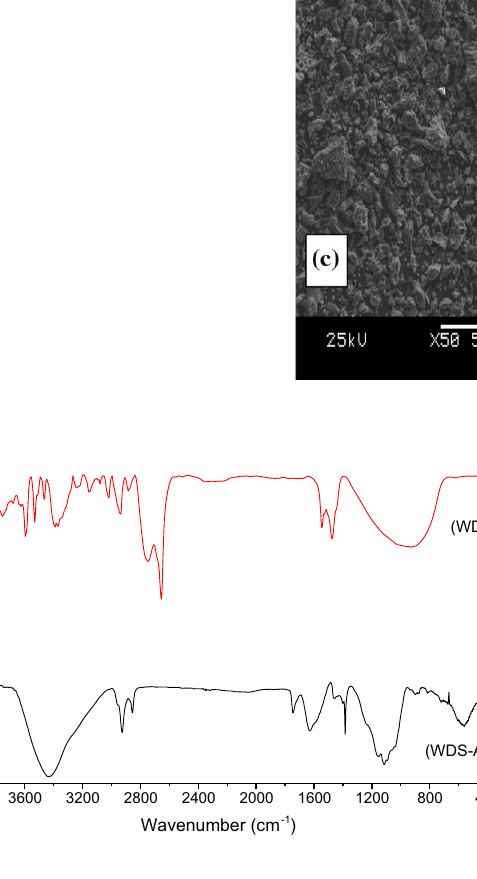
Fig. 3 FTIR spectra of precursor and 1120 cm −1 . Finely, the new peak at 1540 cm −1 corresponds to the C–C stretching vibration.